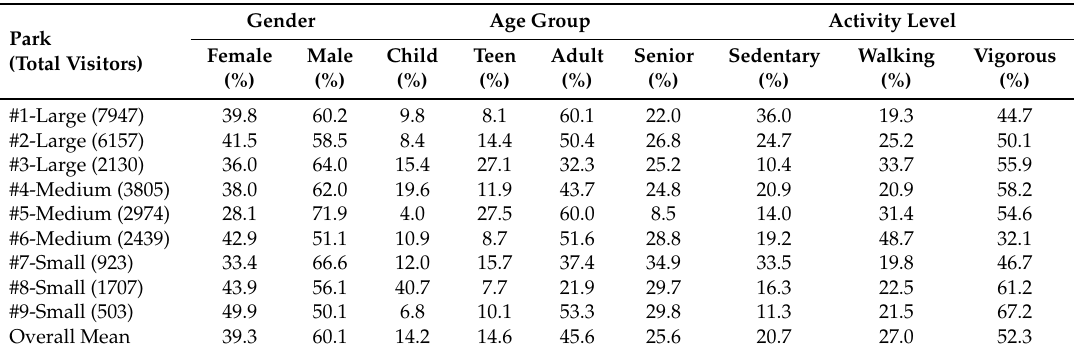
Table 3. Number and proportion of observed park users by gender, age group, and physical activity level overall and in each park (total visitors = 28,585).